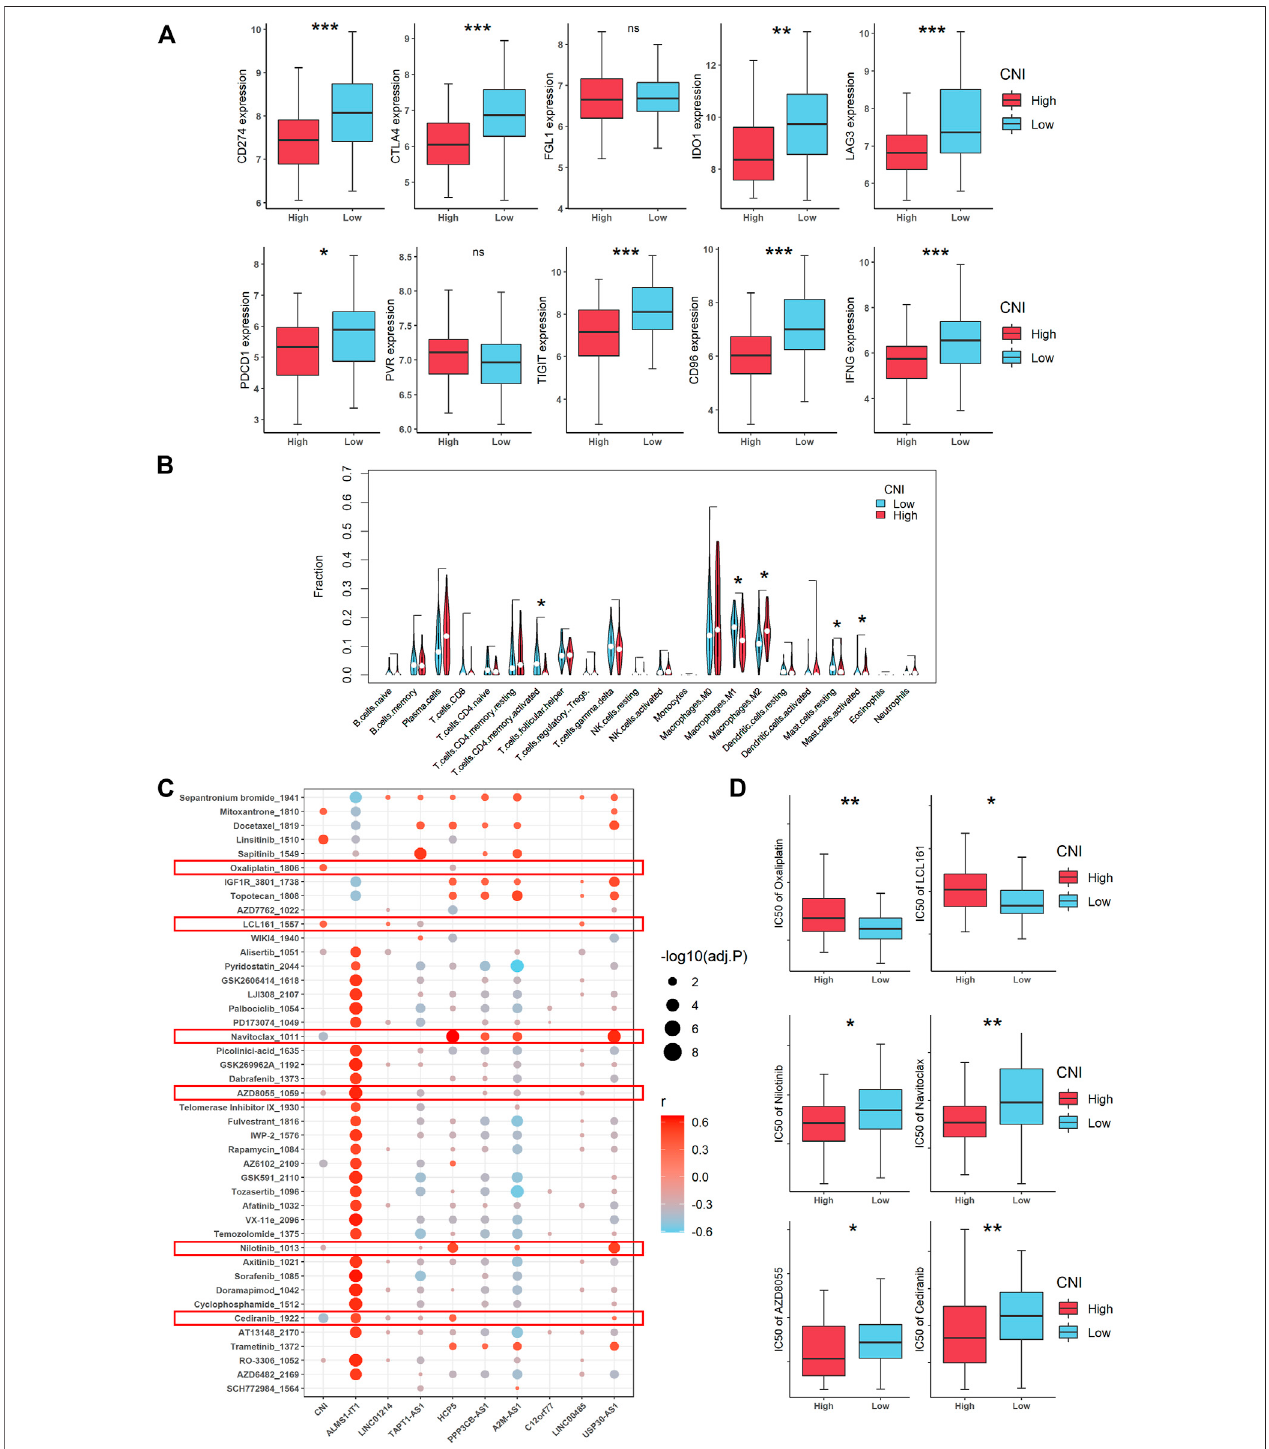
FIGURE 9 | Landscape of tumor immune microenvironment and drug sensitivity in patients with TNBC according to the CNI value (***, **, *, and ns indicate p < 0.001, < 0.01, < 0.05,andnosigni fi cance,respectively). (A) Expressionlevelsofvariousimmunecheckpointmoleculesbetweenthehigh-andlow-CNIgroups. (B) Violin plots of the proportions of different immune cell in fi ltration in TNBC with high-CNI and low-CNI. (C) Correlation between 50% inhibiting concentration (IC50) values of variouschemotherapeuticdrugsandnecroptosis-relatedlncRNAs(rreferstocorrelationcoef fi cient). (D) IC50levelsofsomechemotherapeuticdrugsbetweenthe high- and low-CNI groups in TNBC